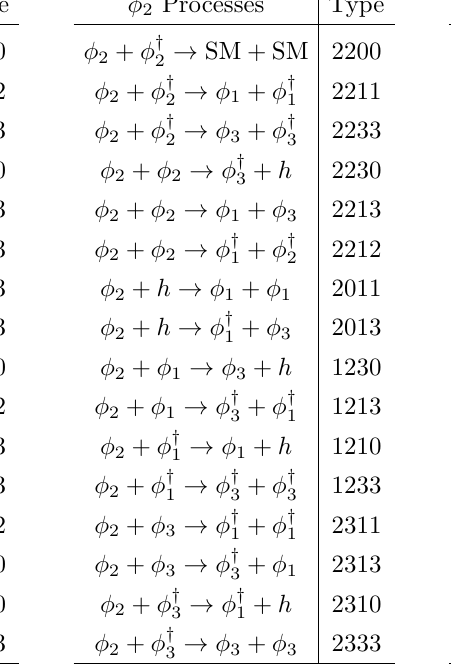
Table 1 . The 2 → 2 processes that are allowed in the Z 7 model and that can modify the relic density of φ 1 (left), φ 2 (center) or φ 3 (right). h denotes the SM Higgs boson. Notice that half of the processes types cannot be found within two-componet dark matter scenarios, as they involve three different dark matter particles. Conjugate and inverse processes are not